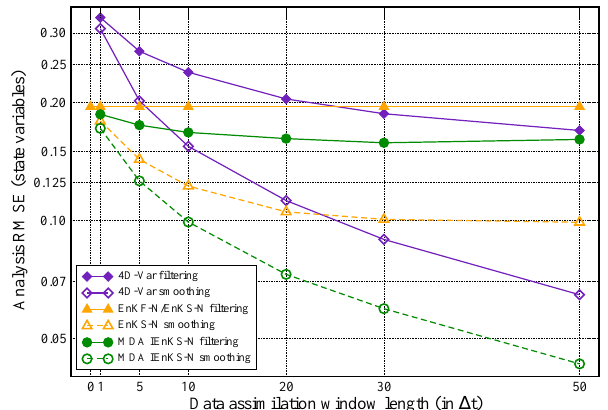
Fig. 5. Plot of the Lorenz-95 forcing parameter F as a function of the cycle index of the data assimilation experiment. F is es- timated by several filters and smoothers with an ensemble of size N = 20 . The forcing of the true model is F = 8 . The MDA IEnKS for L = 1 , 5 , 10 and 30 is compared to the EnKF and the EnKS ( L = 50 ). The finite-size variants of these methods are used: they do not require inflation and perform, in this context, as well as with optimally tuned inflation.